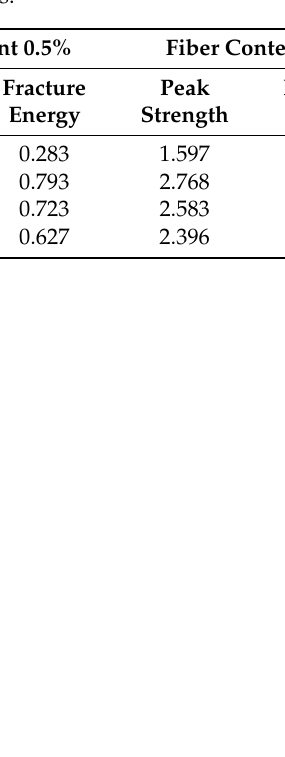
Table 7. Fracture energy and peak strength of the specimens.